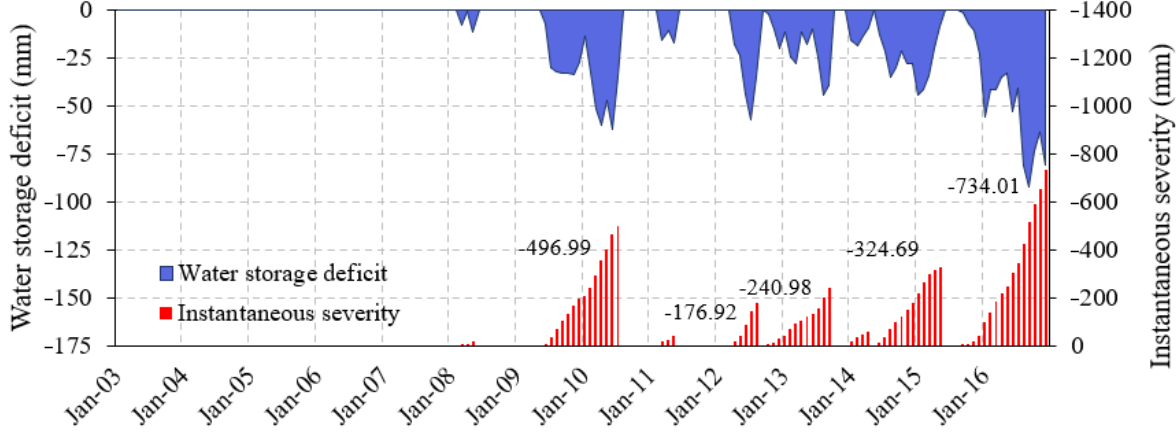
Figure 12. Water storage deficit and instantaneous severity values for the downscaled TWSA data and corresponding overall drought severity values.